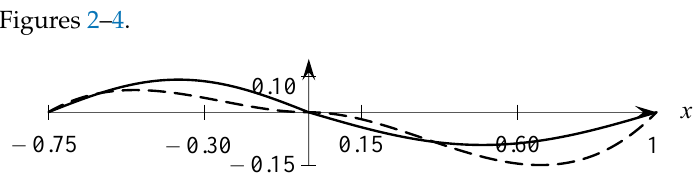
( x ,0 ) ; the dotted line denotes ϕ 1